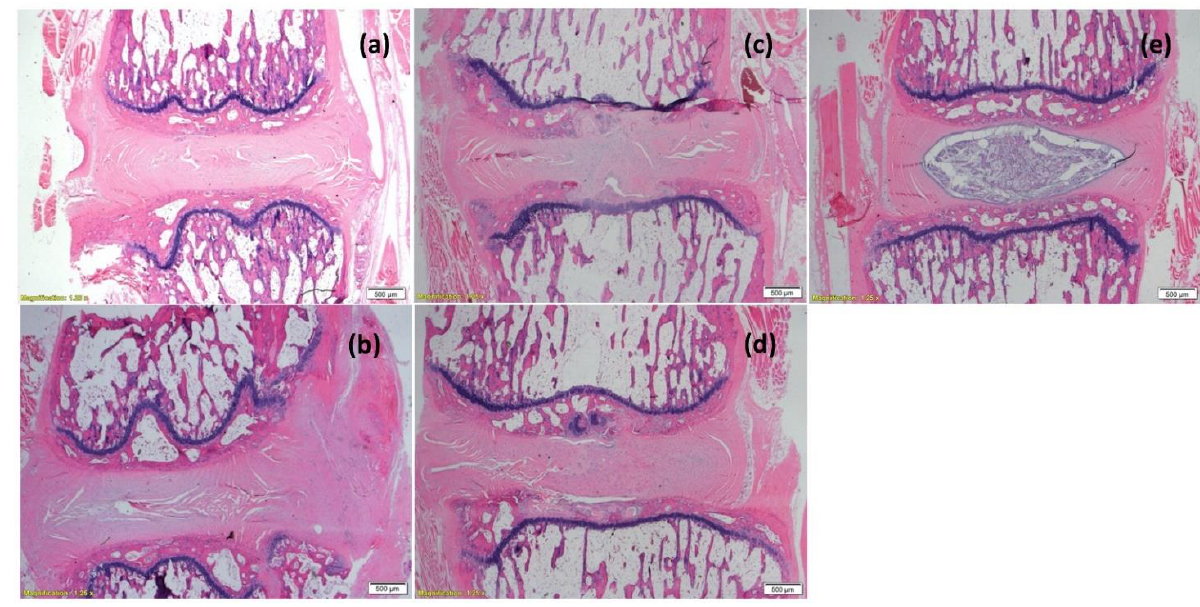
Pharmaceutics 2022 , 14 , x FOR PEER REVIEW 11 of 14 Figure 6. Cross section of a rat intervertebral caudal tail disc with damaged nucleus pulposus 8 weeks post-implantation of hBM-MSC-loaded alginate beads embedded in GAG-analogue hydrogel. Tails were harvested, fixed in 4% formalin, and stained with H&E and DAPI. Cells were stained with Dil (live staining) before seeding in alginate beads. The scale bar is 20 µm.